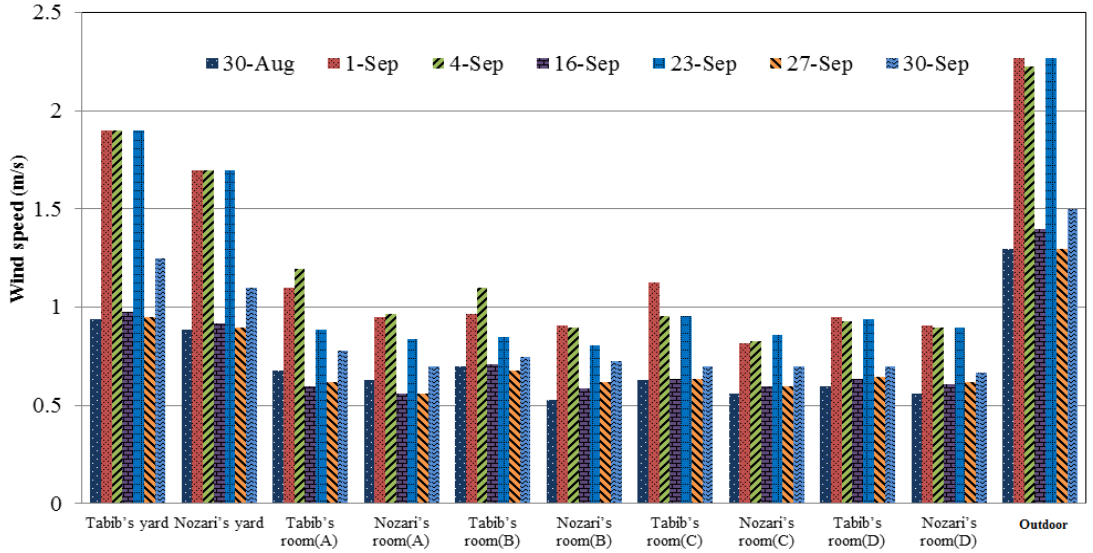
Figure 15 . Wind speed of rooms measured for different days, 2016. Figure 15. Wind speed of rooms measured for different days,